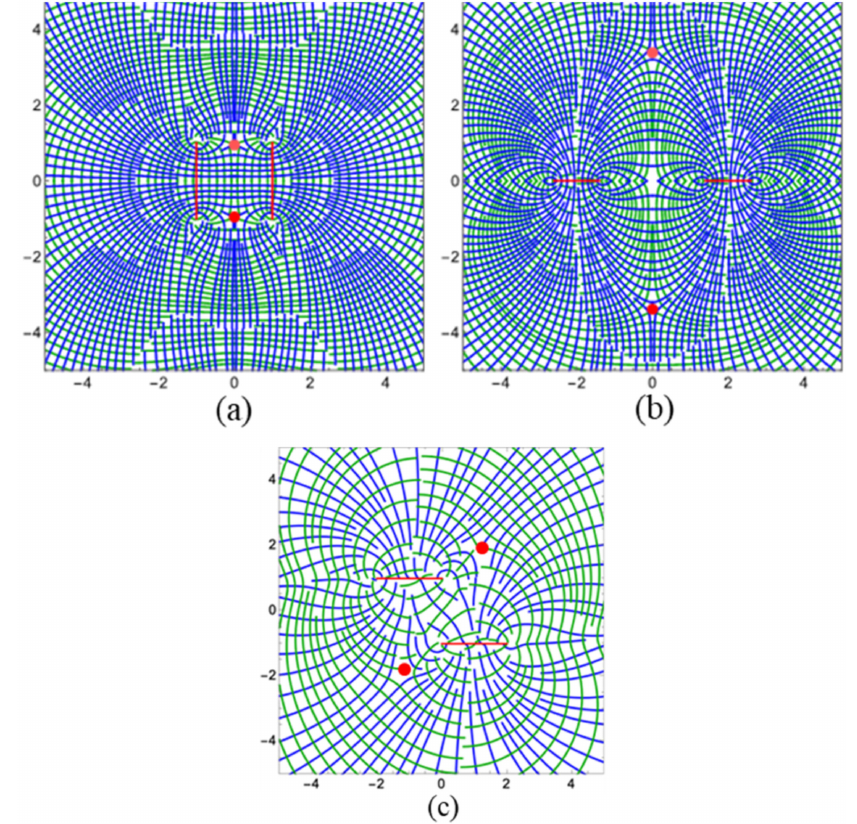
Figure 4. Stress trajectory solutions ( a – c ) for the three fracture constellations shown in Figures 2 and 3. A far-field anisotropic stress field is present, with the largest compressional principal stress trajectories outlined in blue and the least principal stress trajectories outlined in green. Red dots mark neutral points, i.e., locations where the magnitude of the two principal stresses in the plane of view are